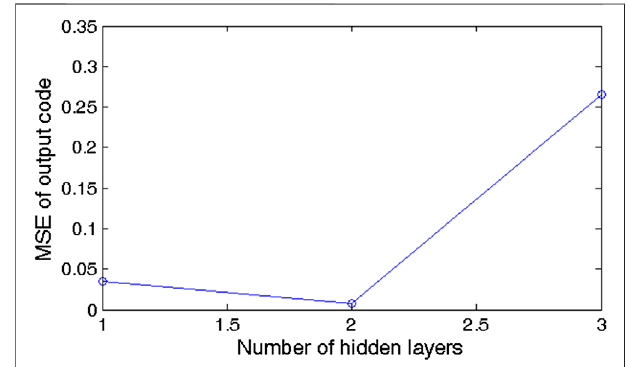
FIGURE 12 | Mean square error curves of different numbers of hidden